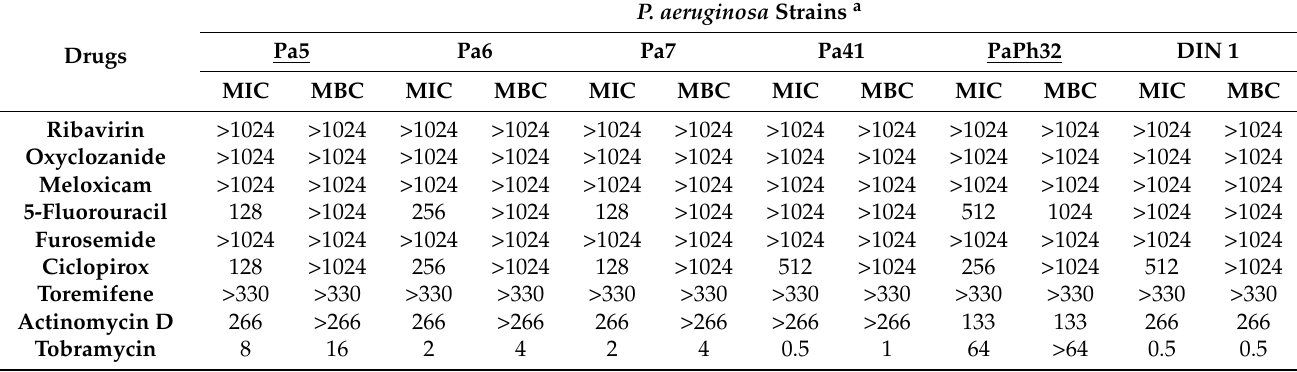
Table 3. Susceptibility of P. aeruginosa CF strains to FDA-approved drugs. MIC and MBC values were measured, comparatively to tobramycin, by the broth microdilution method and expressed as µ g/mL. Differences in the range of tested concentrations are due to limitations in drugs’ solubility. a Tobramycin-resistant strains are